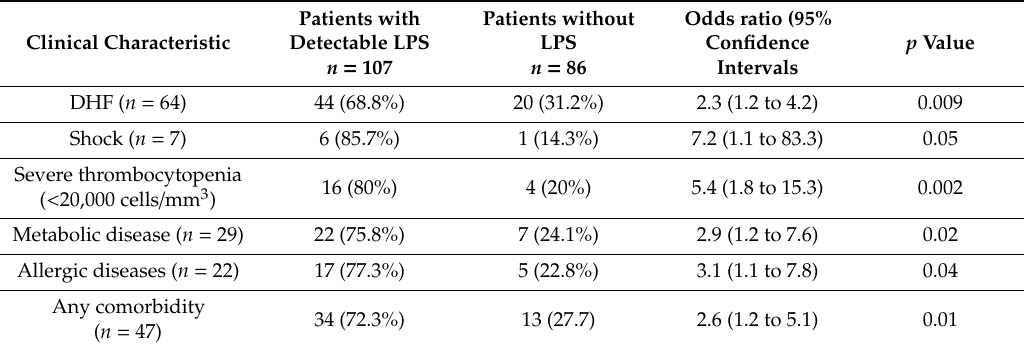
Table 2. Clinical and laboratory characteristics associated with presence of